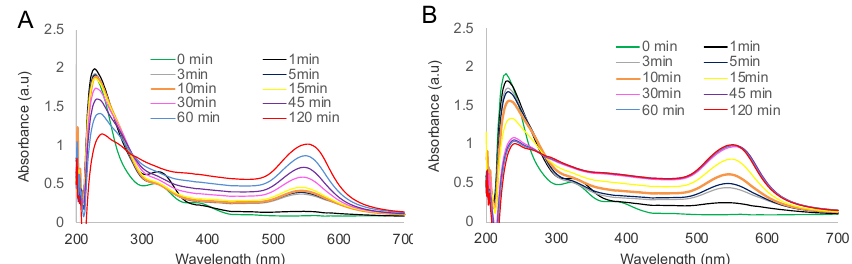
Figure 1. The time evolution of the UV–Vis spectra in the mixtures containing 6.3% w / w F127 and 0.25 mM HAuCl 4 during incubation at 25 °C ( A ) or 45 °C ( B ).